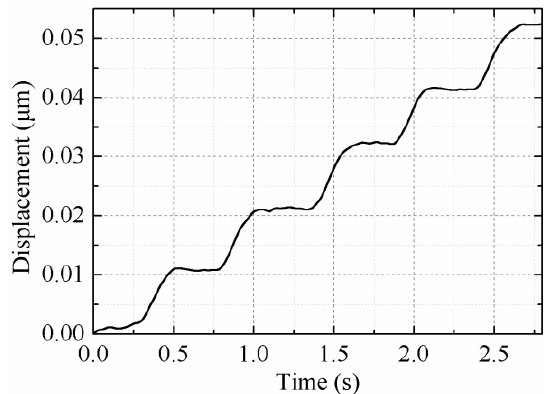
Figure 11. Plot of the displacement under voltage with step increment of 3 V p-p .